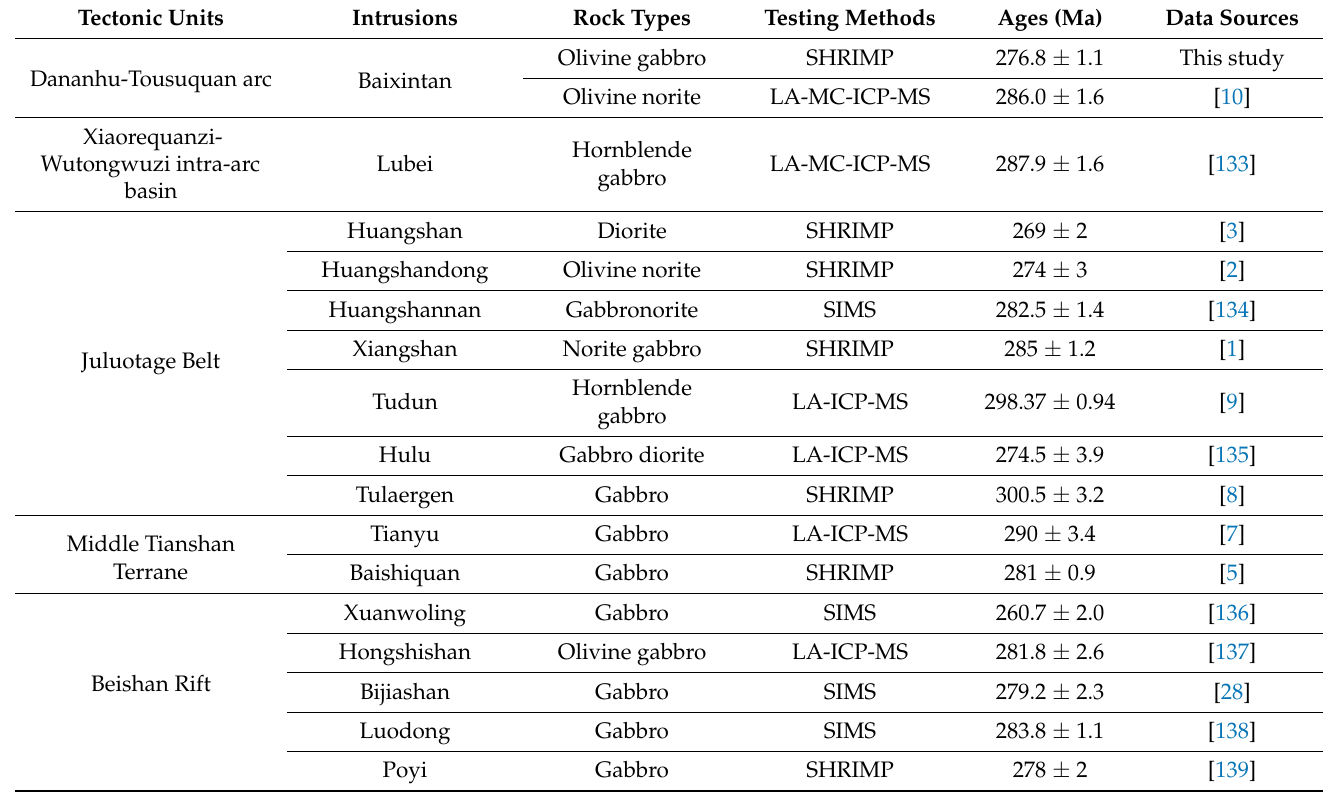
Table 1. Zircon U-Pb ages of intrusion located in the Eastern Tianshan orogenic belt and Beishan Rift. Tectonic